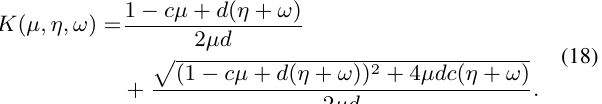
= 1 . The 0 and choose parameter values c + dx